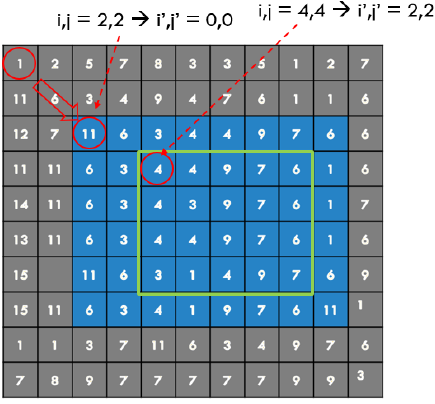
Figure 7. Illustration of extraction solution against clipping attack.